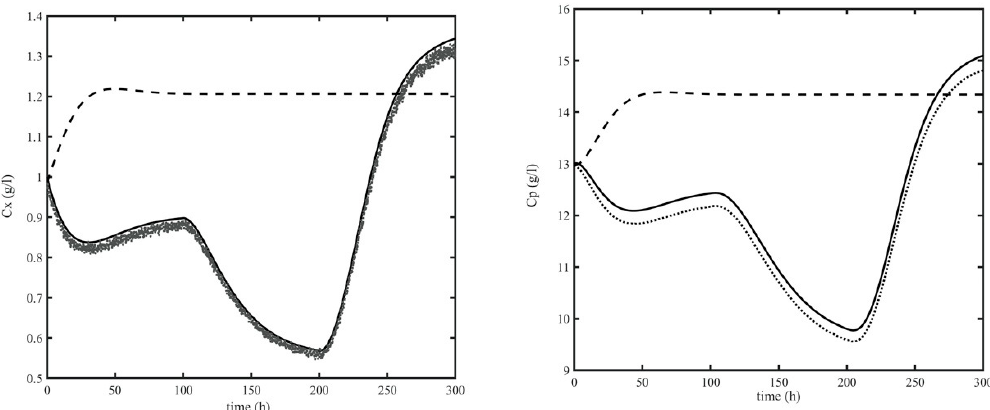
Figure 7. Dynamic response of biomass concentration ( left panel) and ethanol concentration ( right panel) calculated with the virtual plant (continuous line), open-loop model (dashed line) and GO (dotted grey line) for structure φ p3 along the trajectory T3.